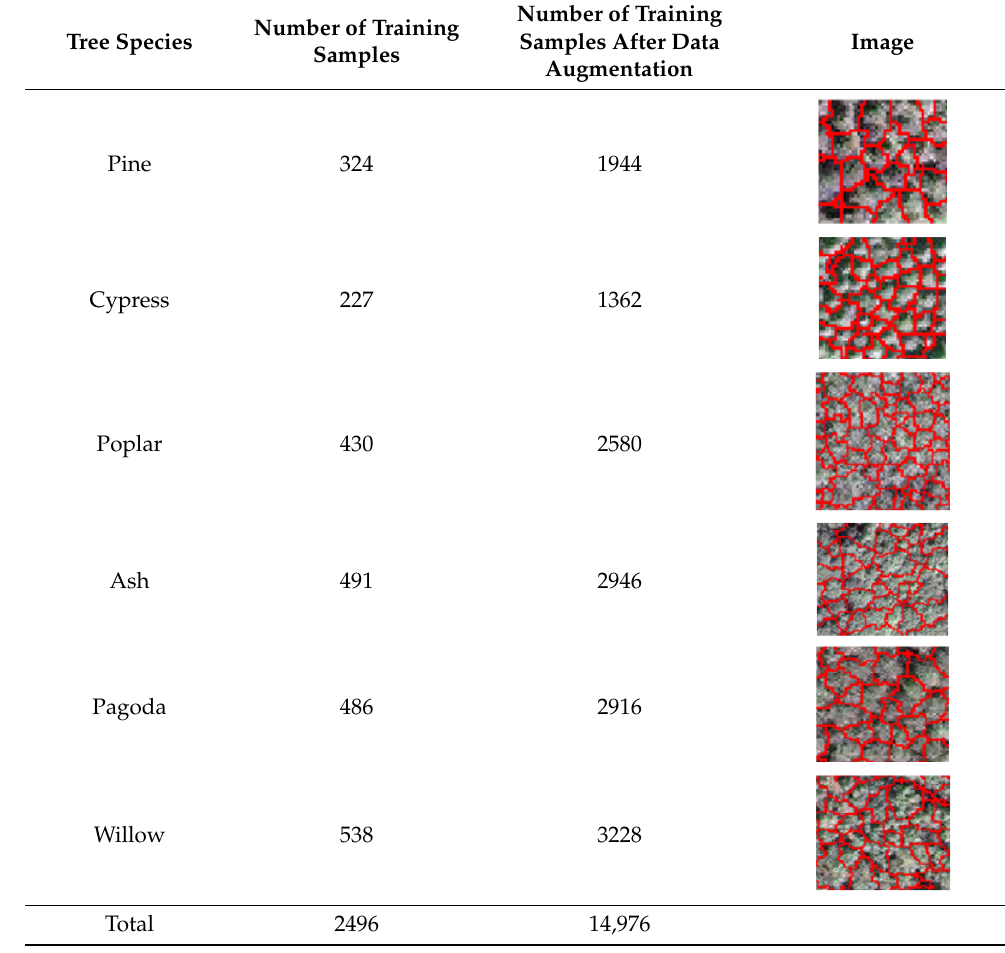
Table 1. The statistics of the training samples.